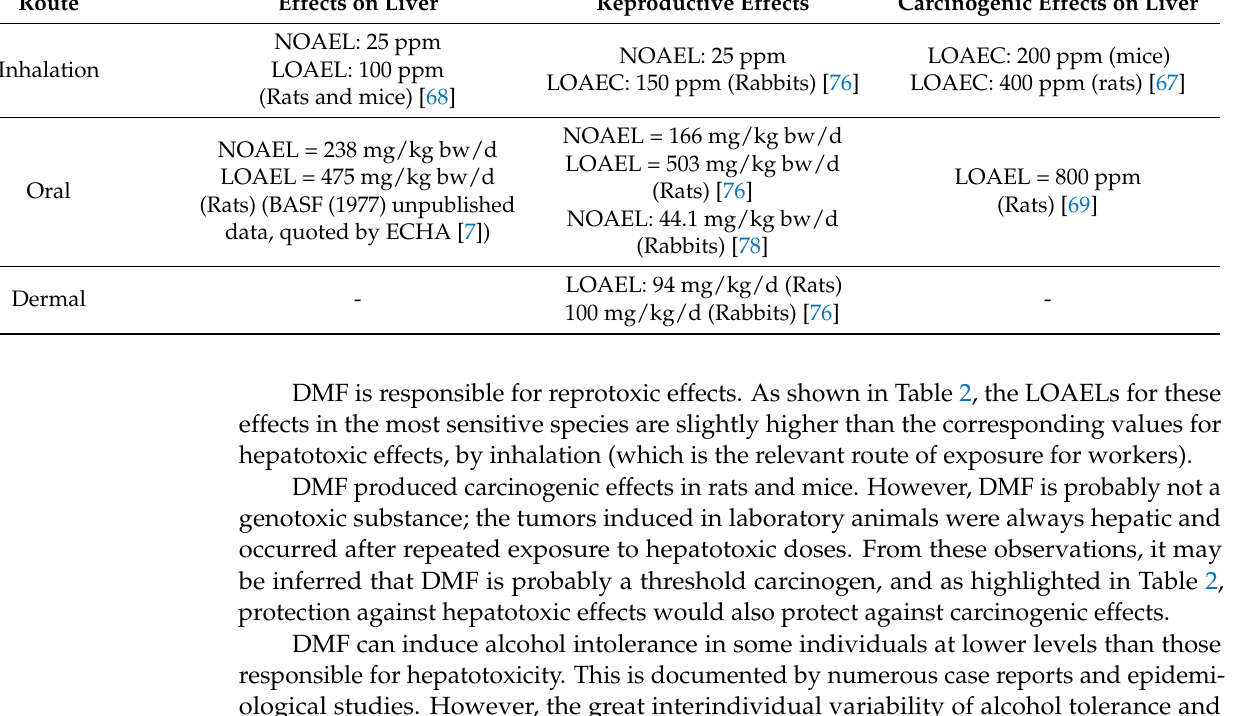
Table 2. Lower points of departure for relevant adverse effects reported in animal studies.